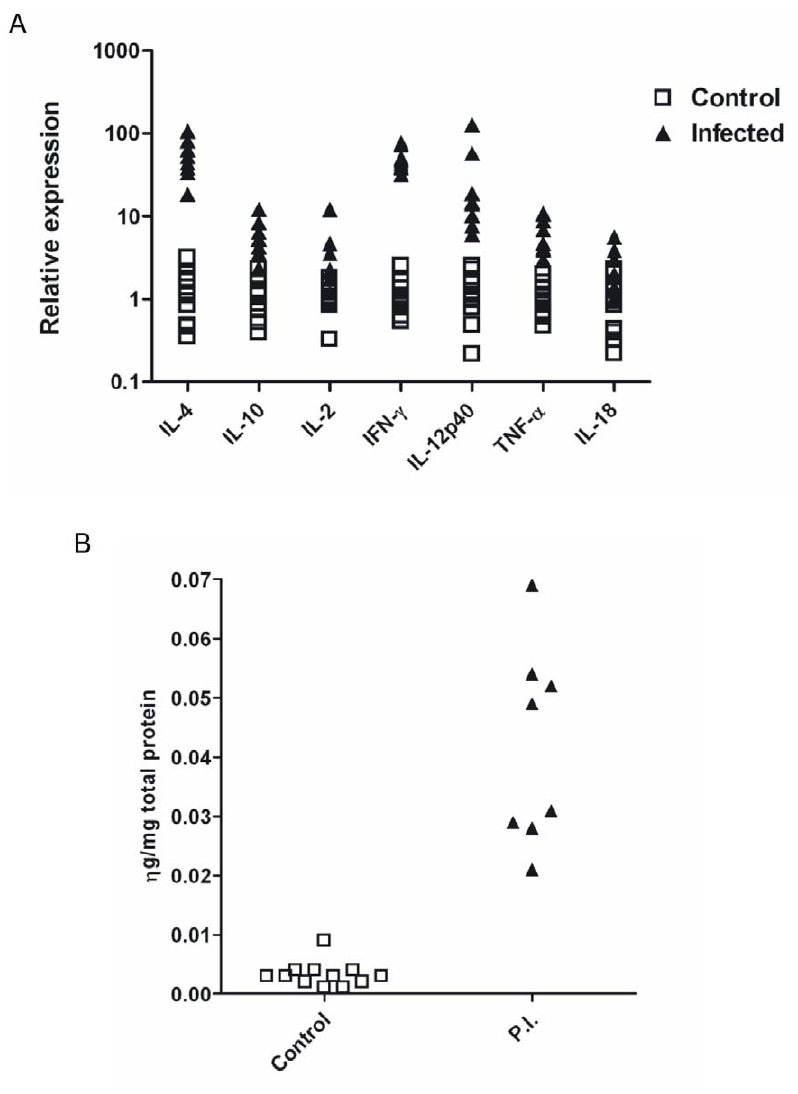
Figure 3. Cytokine responses in placenta of cattle following parasite recrudescence. A. Cytokine mRNA was measured in the caruncle tissue of eight naturally, persistently infected cattle two to four weeks after parasite recrudescence and placental infection. All cytokine mRNAs were significantly up regulated in caruncle from infected cows compared to 12 uninfected cows euthanized at 13 (n=6) and 33 (n=6) weeks of gestation. IL4 and IFN- c were most highly up regulated (by 48.7 and 45.8 fold respectively p , 0.0001). IL-12p40 increased by 14.6 fold, IL-10 by 5.4 fold and TNF- a by 5.9 fold (p , 0.0001). IL-2 increased by 2.9 fold (p , 0.01) and IL-18 increased by 1.9 fold (p , 0.05). B. Interferon- c protein levels extracted from placental tissue of eight cows following recrudescence of a naturally acquired, persistent N. caninum infection. IFN- c was measured by ELISA using the Bovigam IFN- c kit in fluid extracted from the caruncles of ten placentomes per animal. There was a highly significant increase in IFN- c in the caruncles from infected animals – a median of 0.04ng/mg total protein extracted compared to 0.003ng/mg extracted from caruncles from uninfected cattle.